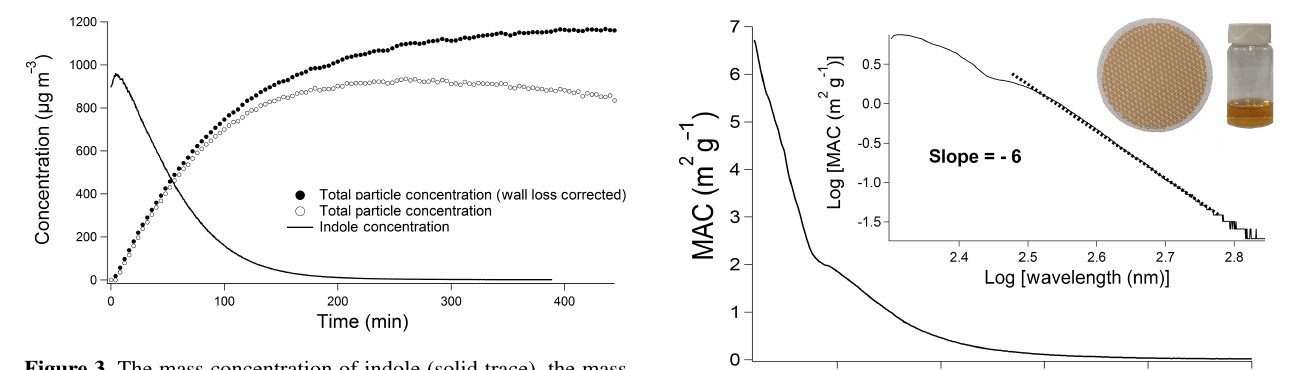
Figure 3. The mass concentration of indole (solid trace), the mass concentration of particles (open circles), and the wall-loss-corrected mass concentration of particles (solid circles) over time. Indole was not yet fully mixed in the chamber by the time photooxidation started at t = 0, resulting in an apparent initial rise in the measured indole concentration.